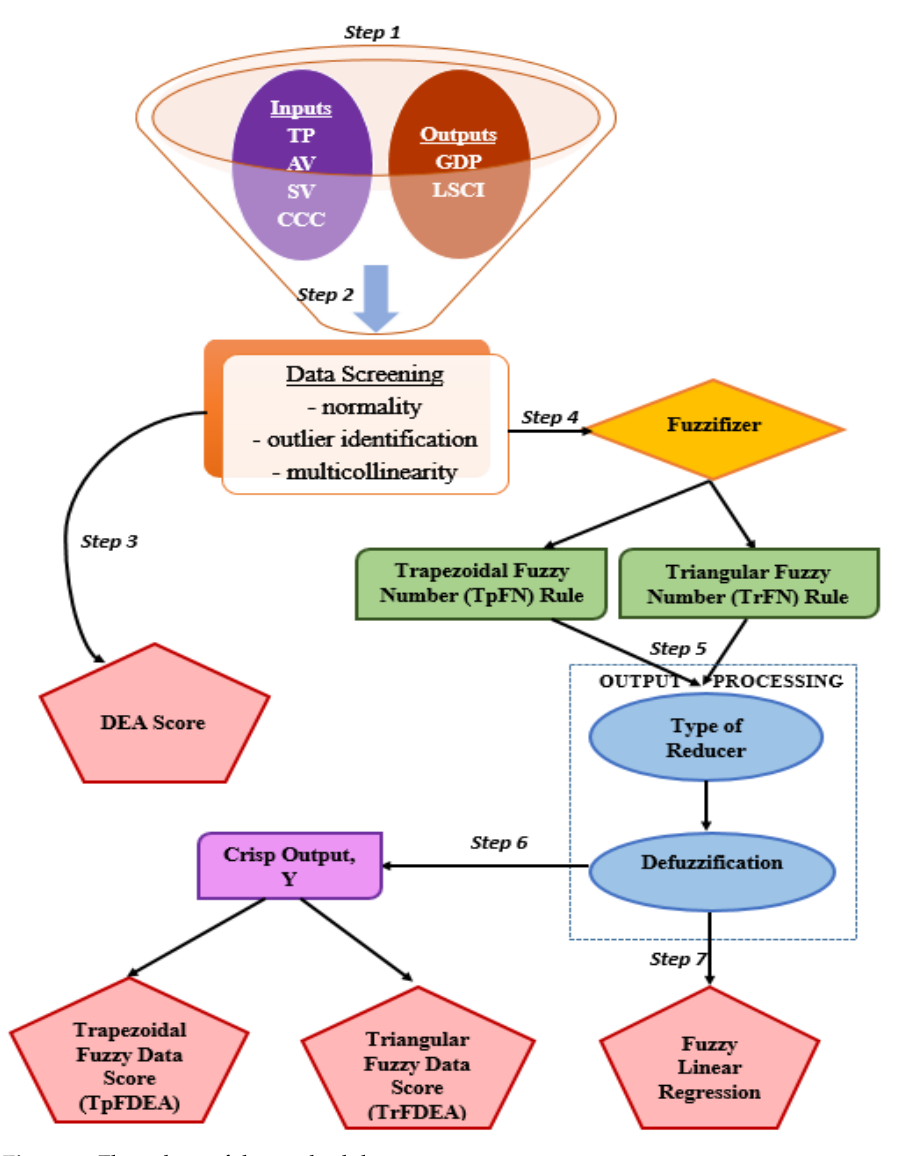
Figure 3. Flow chart of the methodology.